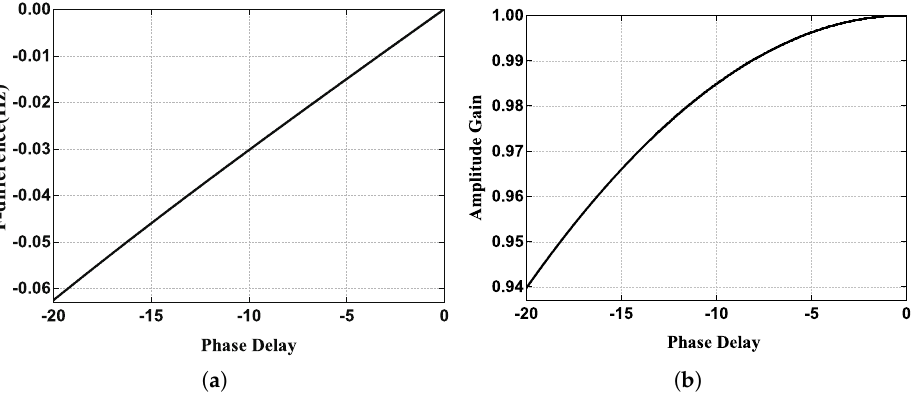
Figure 2. ( a ) The frequency difference between the driving frequency and resonant frequency. ( b ) The normalized value of amplitude gain.